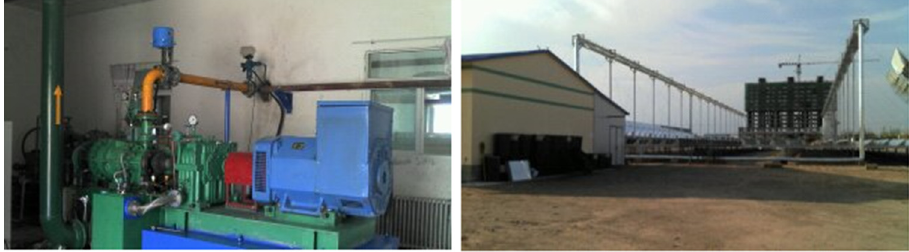
Figure 15. The screw expander generator set of Lanzhou.